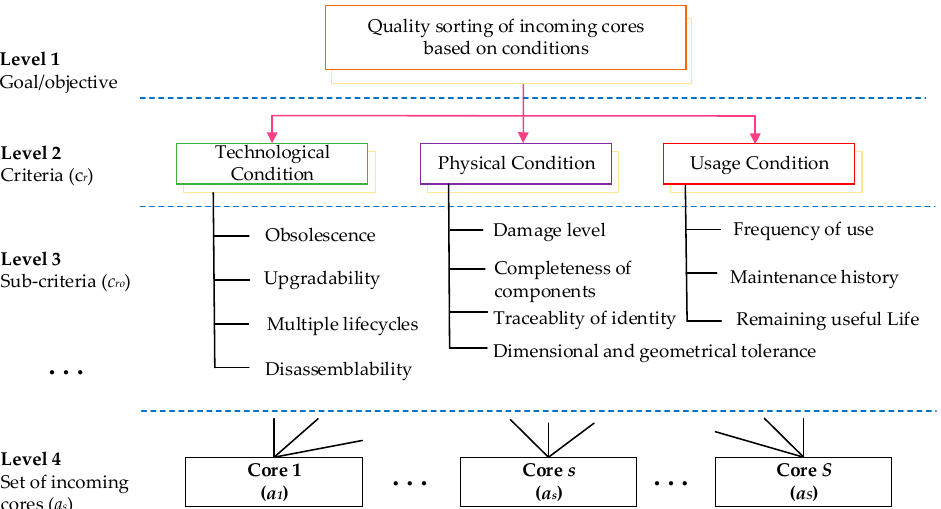
Figure 5. Hierarchy of decision levels for the incoming core quality sorting problem.